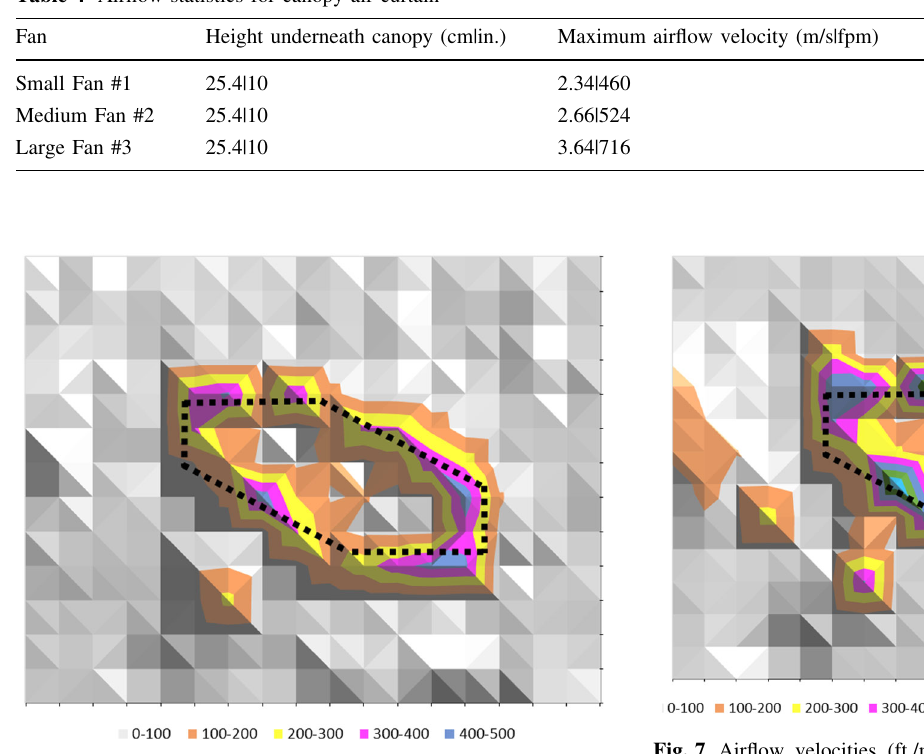
Fig. 5 Airflow velocities (ft./min) at 10-in. height underneath the canopy air curtain using Small Fan #1 & 0.170 m 3 /s (360 cfm). The black dashed line represents the perimeter nozzles of the CAC